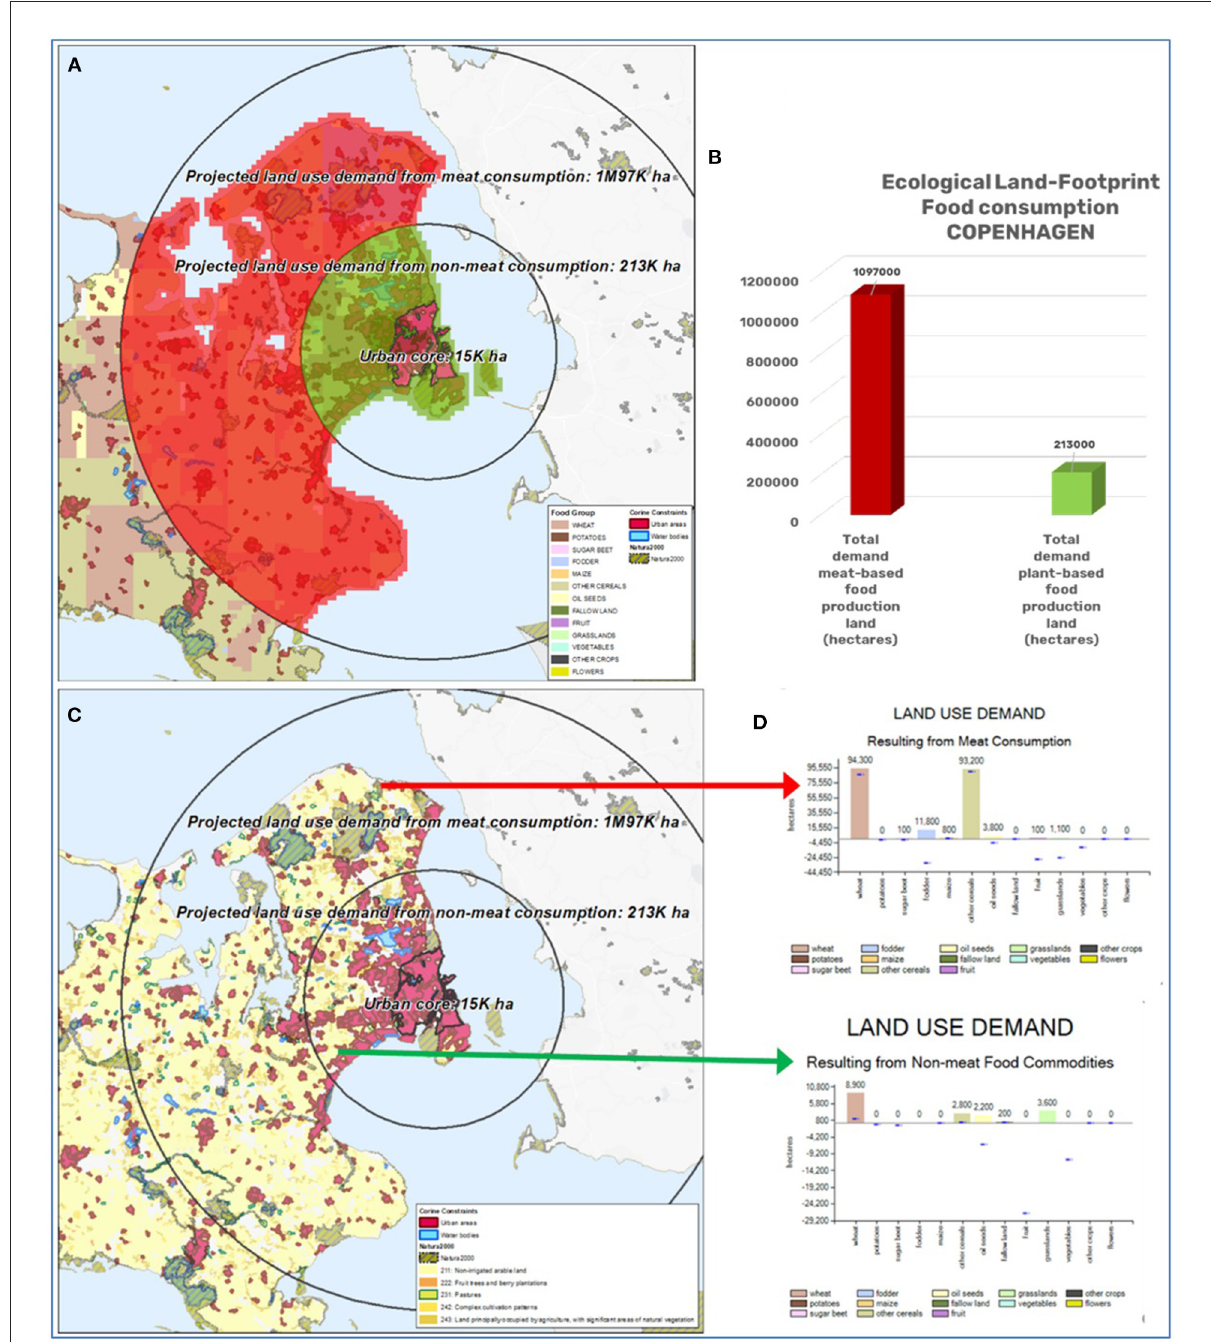
FIGURE5 Land footprint food consumption in Copenhagen: (A) overlaid with map of food groups, and (B) as aggregated total food demand values in hectares. (C) Overlaid with a map of agriculture production zones. (D) Chart showing aggregated food group supply values in hectares within each